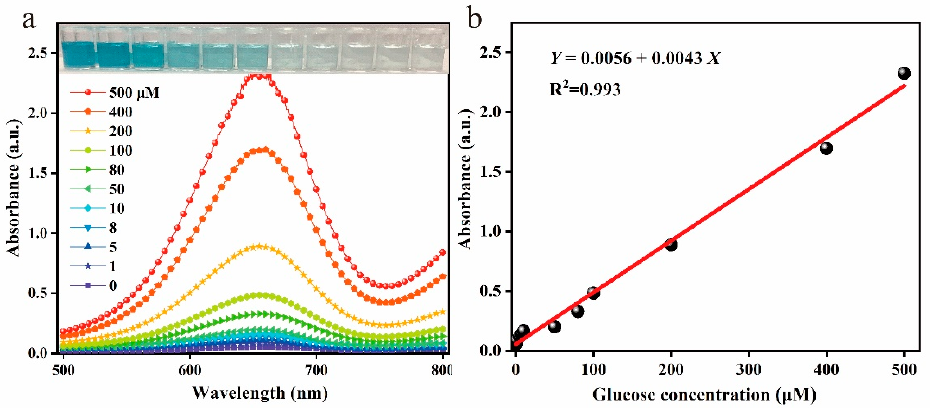
Figure 2. The absorbance value of oxTMB after glucose was catalyzed by ( a ) GOx@GA-Fe (ii) and ( b ) its linear regression